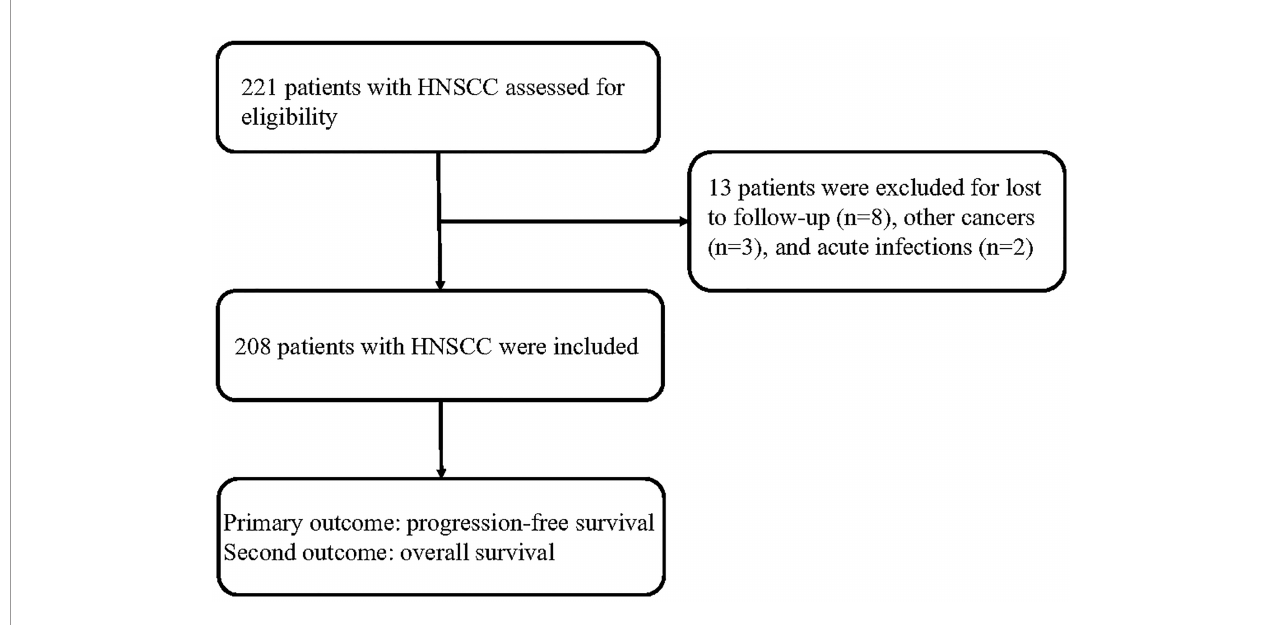
FIGURE 1 | Patients ’ fl ow